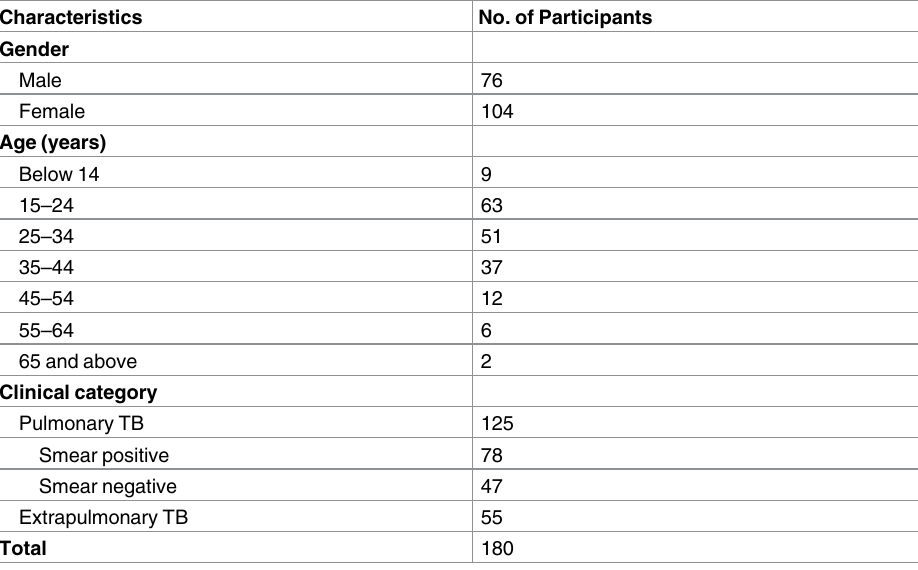
Table 1. Characteristics of study